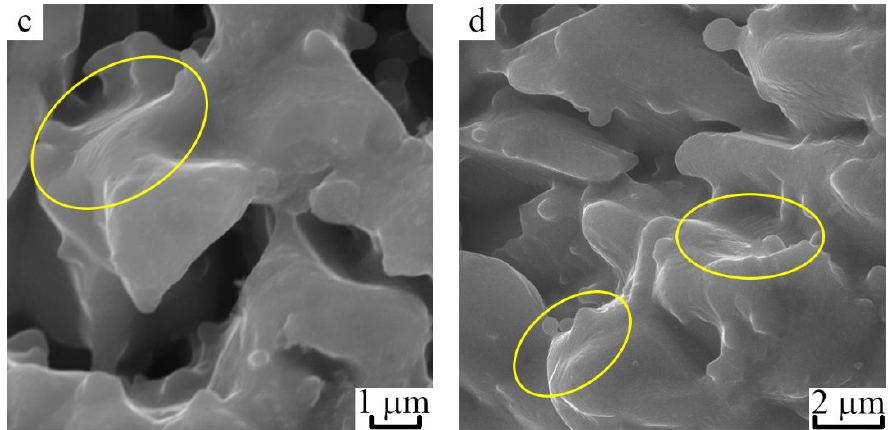
Figure 5. SEM images of the lateral surfaces of the specimens after tensile test at temperature 950 °C, strain rate 4.2 × 10 −4 s −1 and corresponded to different elongation values: ( a ) 40%; ( b ) 100%; ( c ) 400%; ( d ) 900%. Yellow arrows in ( a ) show examples of grain boundary sliding mechanism, and yellow contours in ( c ) and ( d ) show examples of intragranular slip traces.